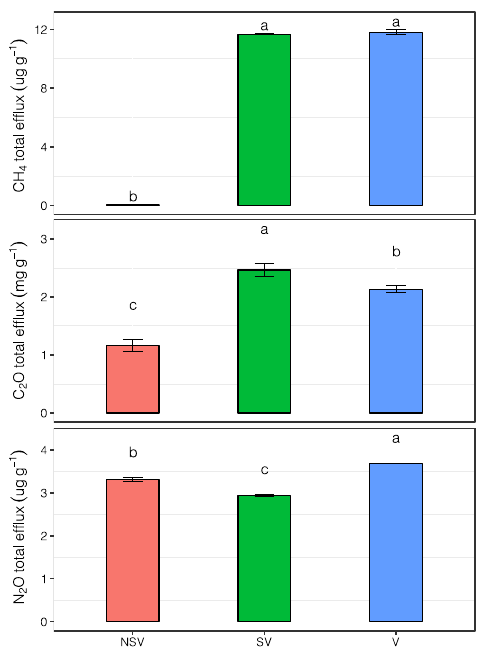
Figure 2. The cumulative emissions of CO 2 , CH 4 , and N 2 O from the NSV, SV, and V treatments. Error bars represent the standard error (n = 3). Bars with different letters indicate a significant difference among treatments ( p < 0.05).